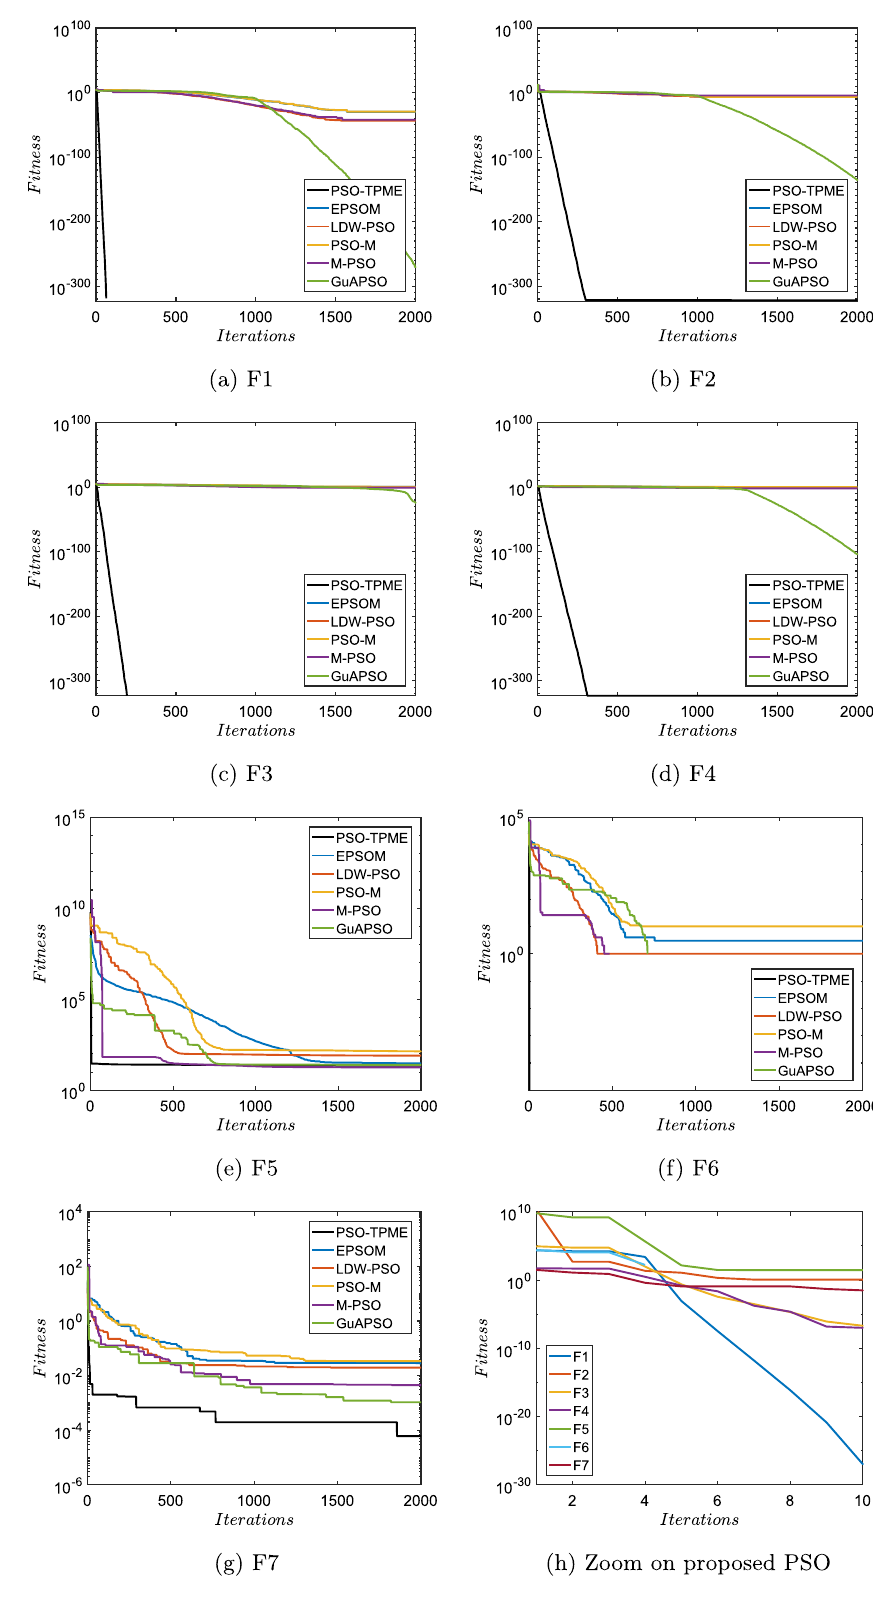
Fig. 4 Fitness performance of PSO variants on multi-dimen- sional benchmark functions. Figures a–g depict comparison of EPSOM, LDW-PSO, PSO- M, M-PSO, and GuAPSO with the proposed PSO on uni-modal 30-dimensional functions (F1 - F7). Figure h shows a zoomed- in plot of the first 10 iterations performance of the proposed PSO on the F1 -